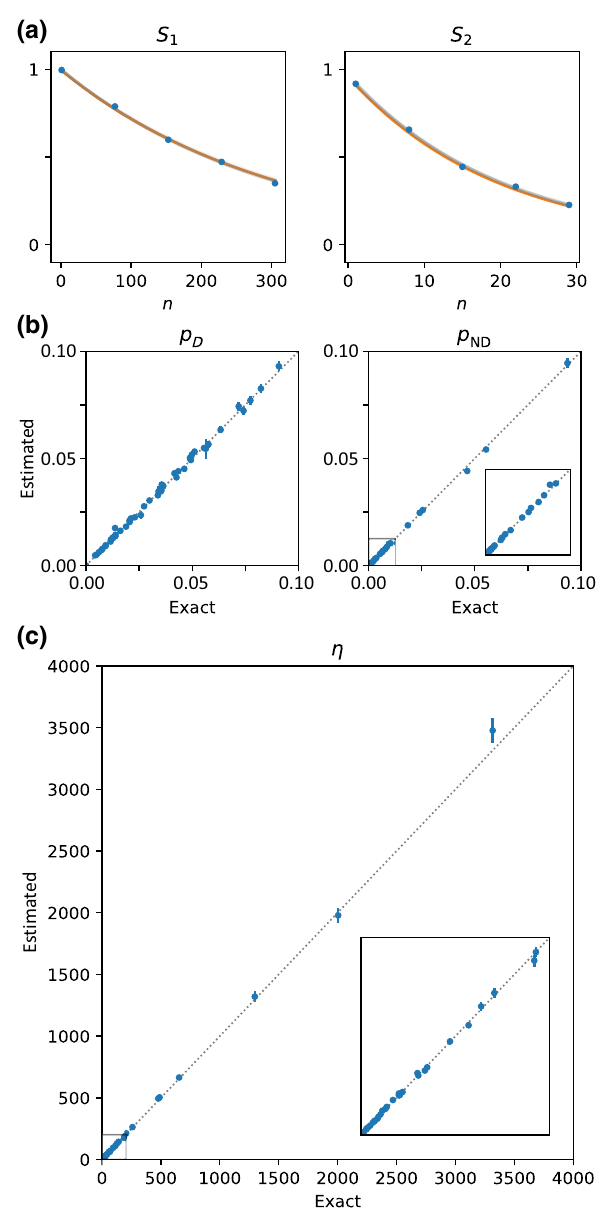
FIG. 1. Simulated CX -dihedral-bias-RB experiments. (a) An example of estimating S b ( n ) , with the S b ( n ) curves plotted in orange and our estimates of S b ( n ) given by blue dots. To estimate sensitivity to statistical errors, we generate multiple fits of S b ( n ) using bootstrap resampling of our data, which are plotted in gray and generally overlap the exact S b ( n ) curves. (b) The probabili- ties p D and p ND extracted from the fits for 50 randomly generated error channels. The error bars denote the standard deviation over 50 resamplings. (c) The estimated bias η for each of these error channels. We see that even at very high bias, we can accurately estimate the value of η